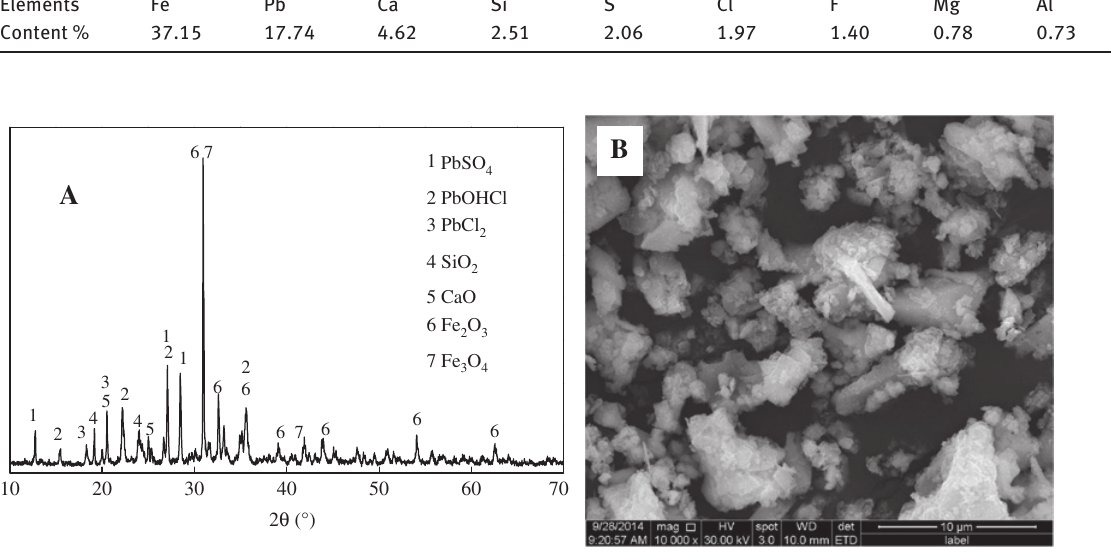
Figure 1: X-ray diffraction pattern (A) and scanning electron microscope image (B) of WLR-SD.